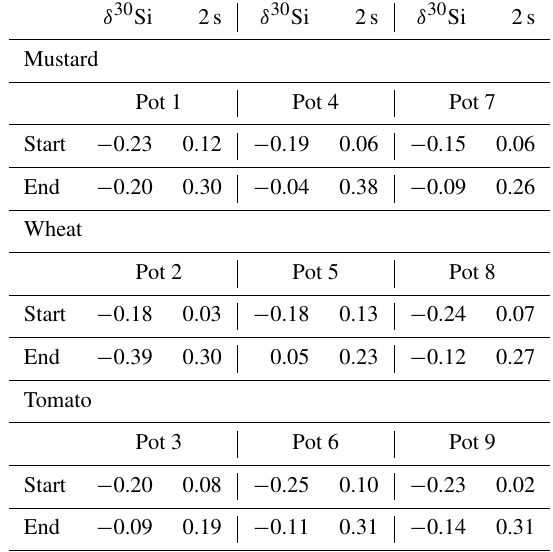
Table 4. Silicon isotope budget (calculated using Eq. 5) for mus- tard, wheat, and tomato at the start of the experiment (based on the isotopic composition of the nutrient solution) and the end (based on the plants and nutrient solution isotopic